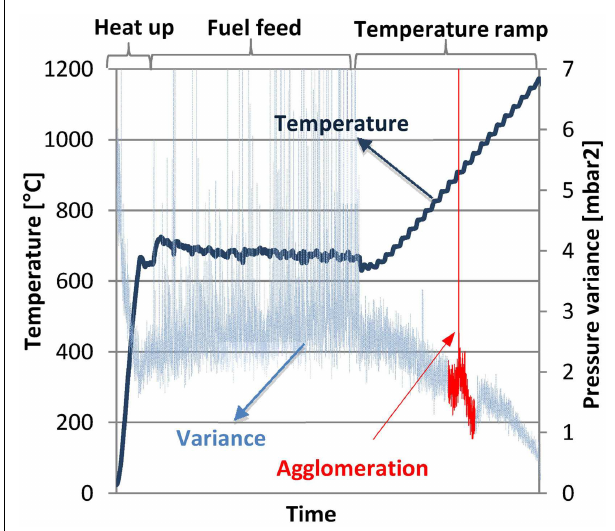
FIGURE 3 | Data-log of an agglomeration experiment showing the three phases of heat-up, ash accumulation (fuel feed), and step-wise temperature increase to induce agglomeration . Detection of defluidisation is based on evaluation of pressure variance as described by Scala and Chirone (2006).